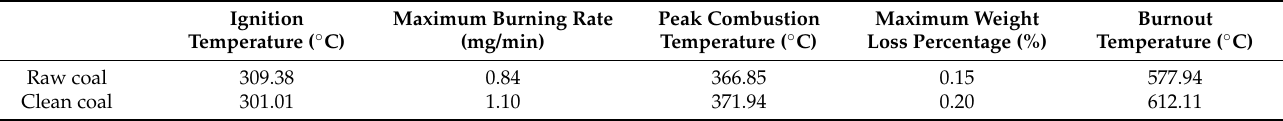
Table 3. Combustion characteristics of raw coal and clean coal.